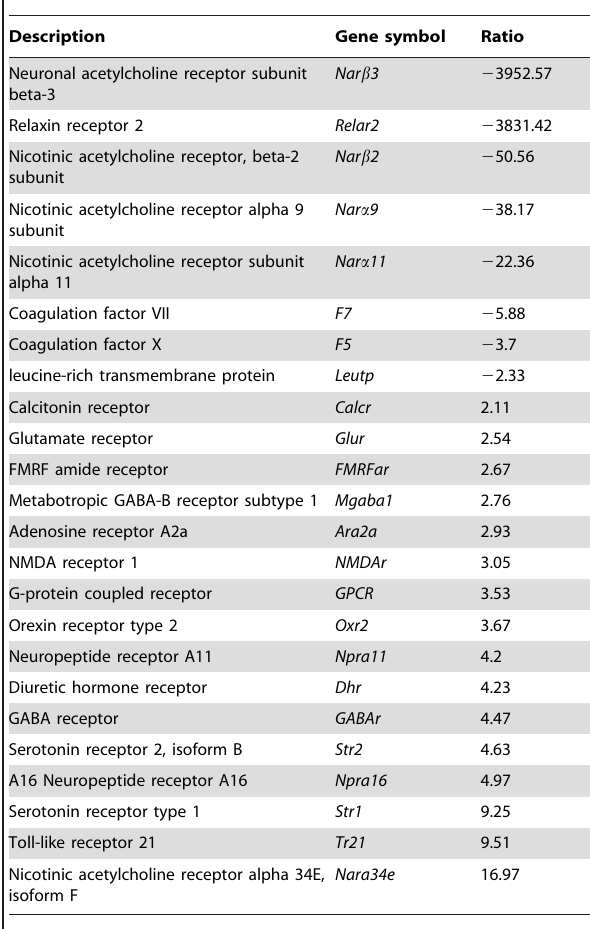
Table 7. Genes in neuroactive ligand-receptor interaction